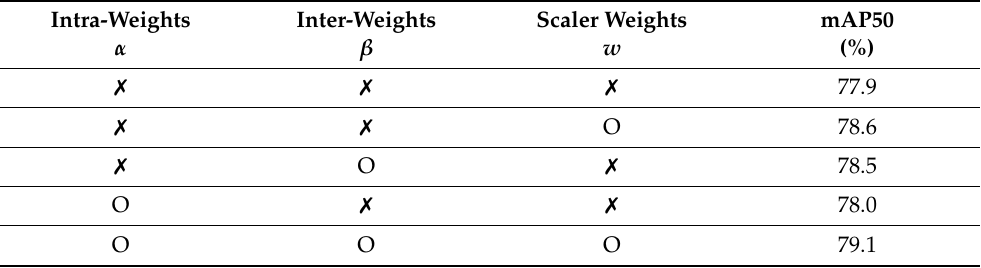
Table 3. Quantitative results for evaluating the effects of learnable weights on the FLIR